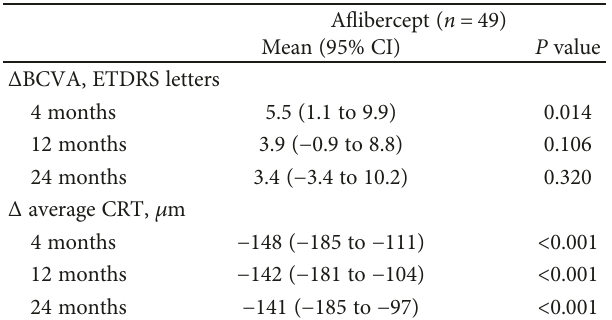
Table 3: Two-year results on A fl ibercept treatment for neovascular age-related macular degeneration in patients aged ≥ 90